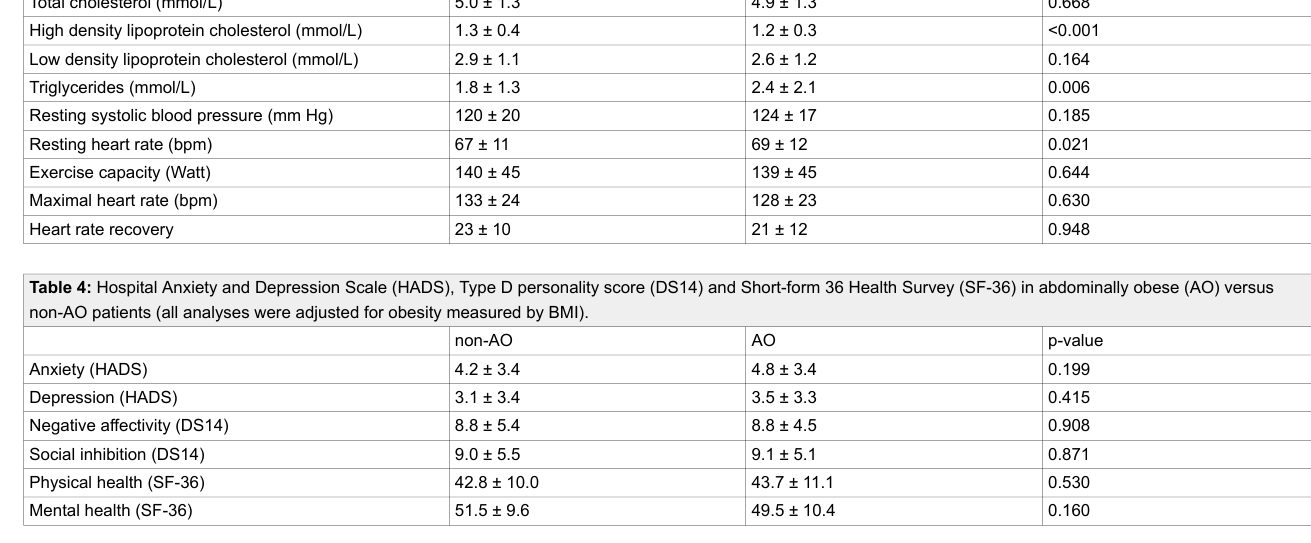
Table 3: Laboratory assessment and exercise testing in abdominally obese (AO) versus non-AO patients (p-values were corrected for age, beta-blocker use, statin use and obesity measured by BMI). non-AO